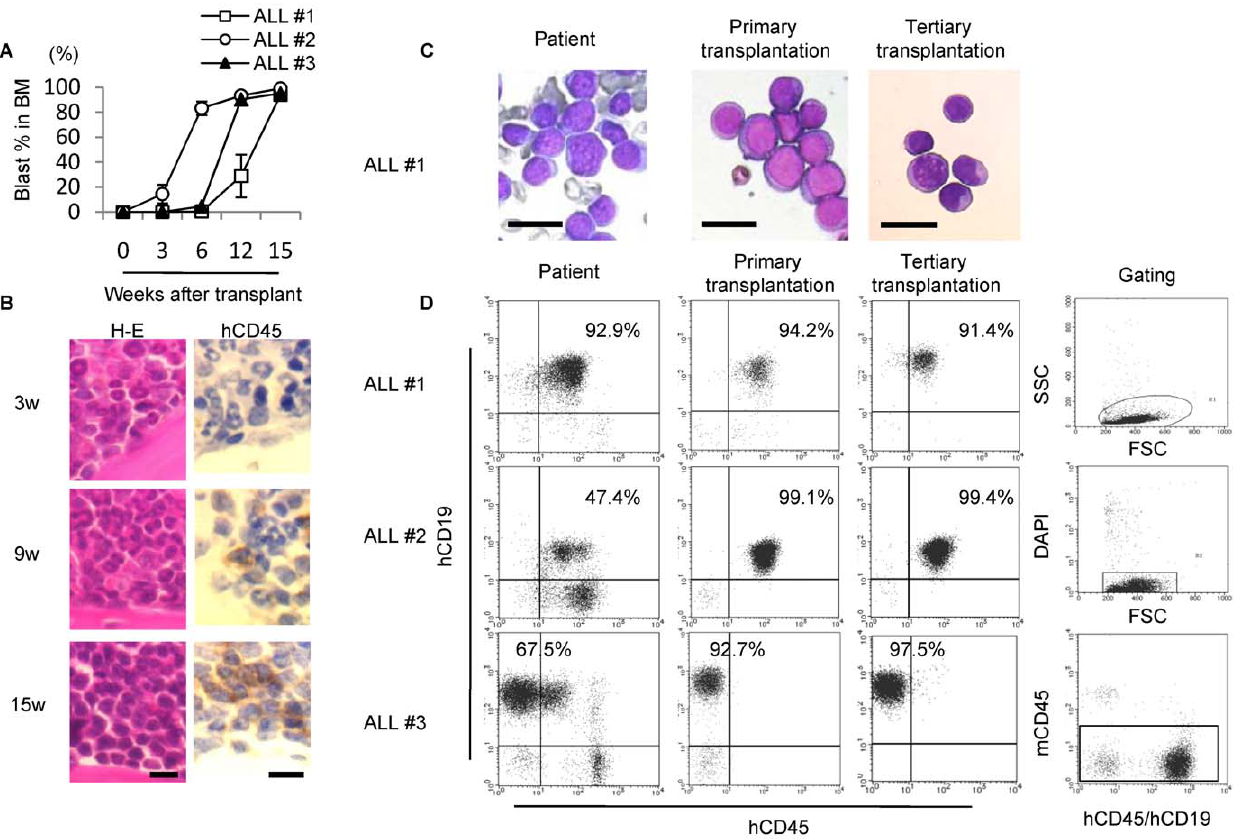
Figure 1. Leukemic cells can be engrafted to NOG mice without pre-conditioning. Morphology ( May-Grunwald Giemsa staining) and immunophenotype of leukemic blasts remain stable during serial transplantation in NOG mice. (A) Sequential FACS analyses showing bone marrow engraftment after transplantation. Graphs show percentage of blast cells (hCD45 or hCD19 positive cells) in recipient BM ( n =3 2 6 mice per case).Data are shown as means 6 S.D. (B) H-E staining and anti-hCD45 immunostaining showing increasing number of leukemic cells over time in the humerus of ALL # 1 leukemic cell-recipient NOG mice. Scale bar, 10 m m. (C) Morphology and (D) immunophenotype of original patient blast cells (left row) and BM samples derived from murine primary and tertiary transplants of leukemic cells (middle and right rows). Debris (low forward scatter), dead cells (DAPI- positive), and mouse CD45 positive cells were excluded from analysis. Scale bar, 20 m m.